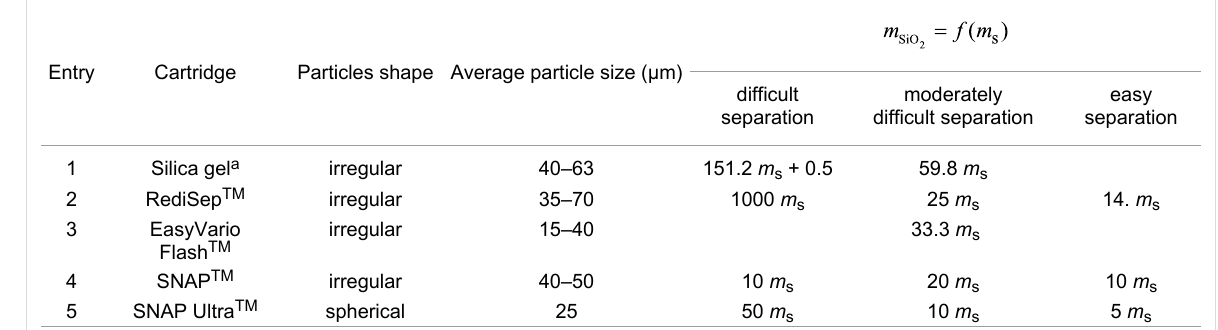
Table 1: Mass of silica (in grams) to be used depending on the mass of sample to be purified for manually packed columns and some commercial pre-packed